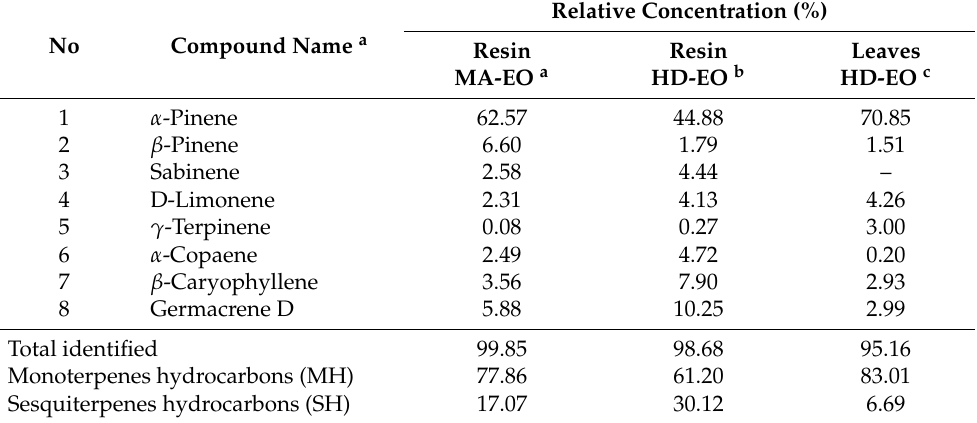
Table 2. Main compounds of the EOs of the Egyptian Araucaria heterophylla in the current study (MA-EO) and those reported for the EOs that were extracted with hydrodistillation (HD-EO) from resin and